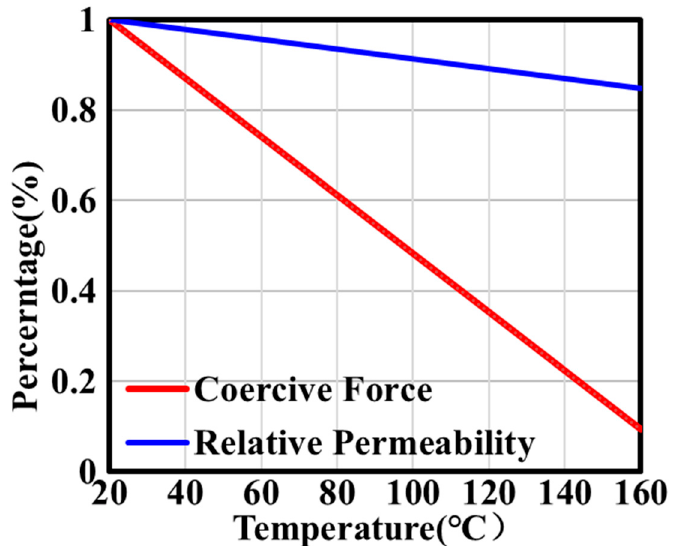
Figure 4. PM relative permeability and coercive force.